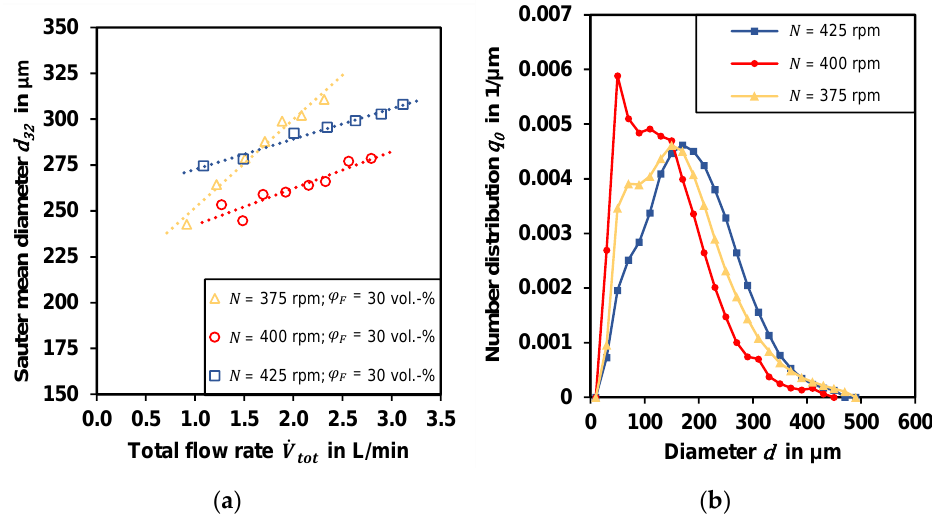
Figure 11. ( a ) Sauter mean diameters at measurement position 𝑀𝑃 1 at a feed phase ratio of 30 vol.-%. ( b ) Measured DSD at different impeller speed at measurement position 𝑀𝑃 1 , a feed phase ratio of 𝜑 𝐹 = 30 vol.-%, and a total flow rate 𝑉 ̇ 𝑡𝑜𝑡 = 1.33 L/min. The lines are a guide to the eye.